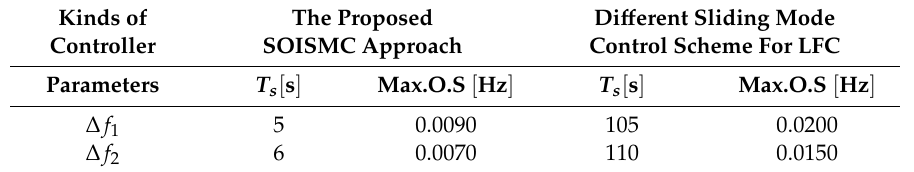
Figure 14. Control input [p.u.] of two control areas under mismatched disturbances. Table 3. Setting time T s and Maximum over shoot calculation of SOISMC and di ff erent SMC method. Kinds of The Proposed Di ff erent Sliding Mode Controller SOISMC Approach Control Scheme For LFC